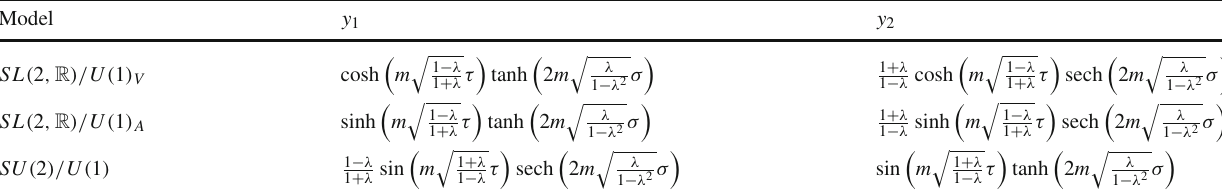
Table 6 The kink limit of the static solutions of the second class for λ > 0. Translationally invariant ones are obtained via σ ↔ τ , while the λ < 0, are obtained using the duality (7)